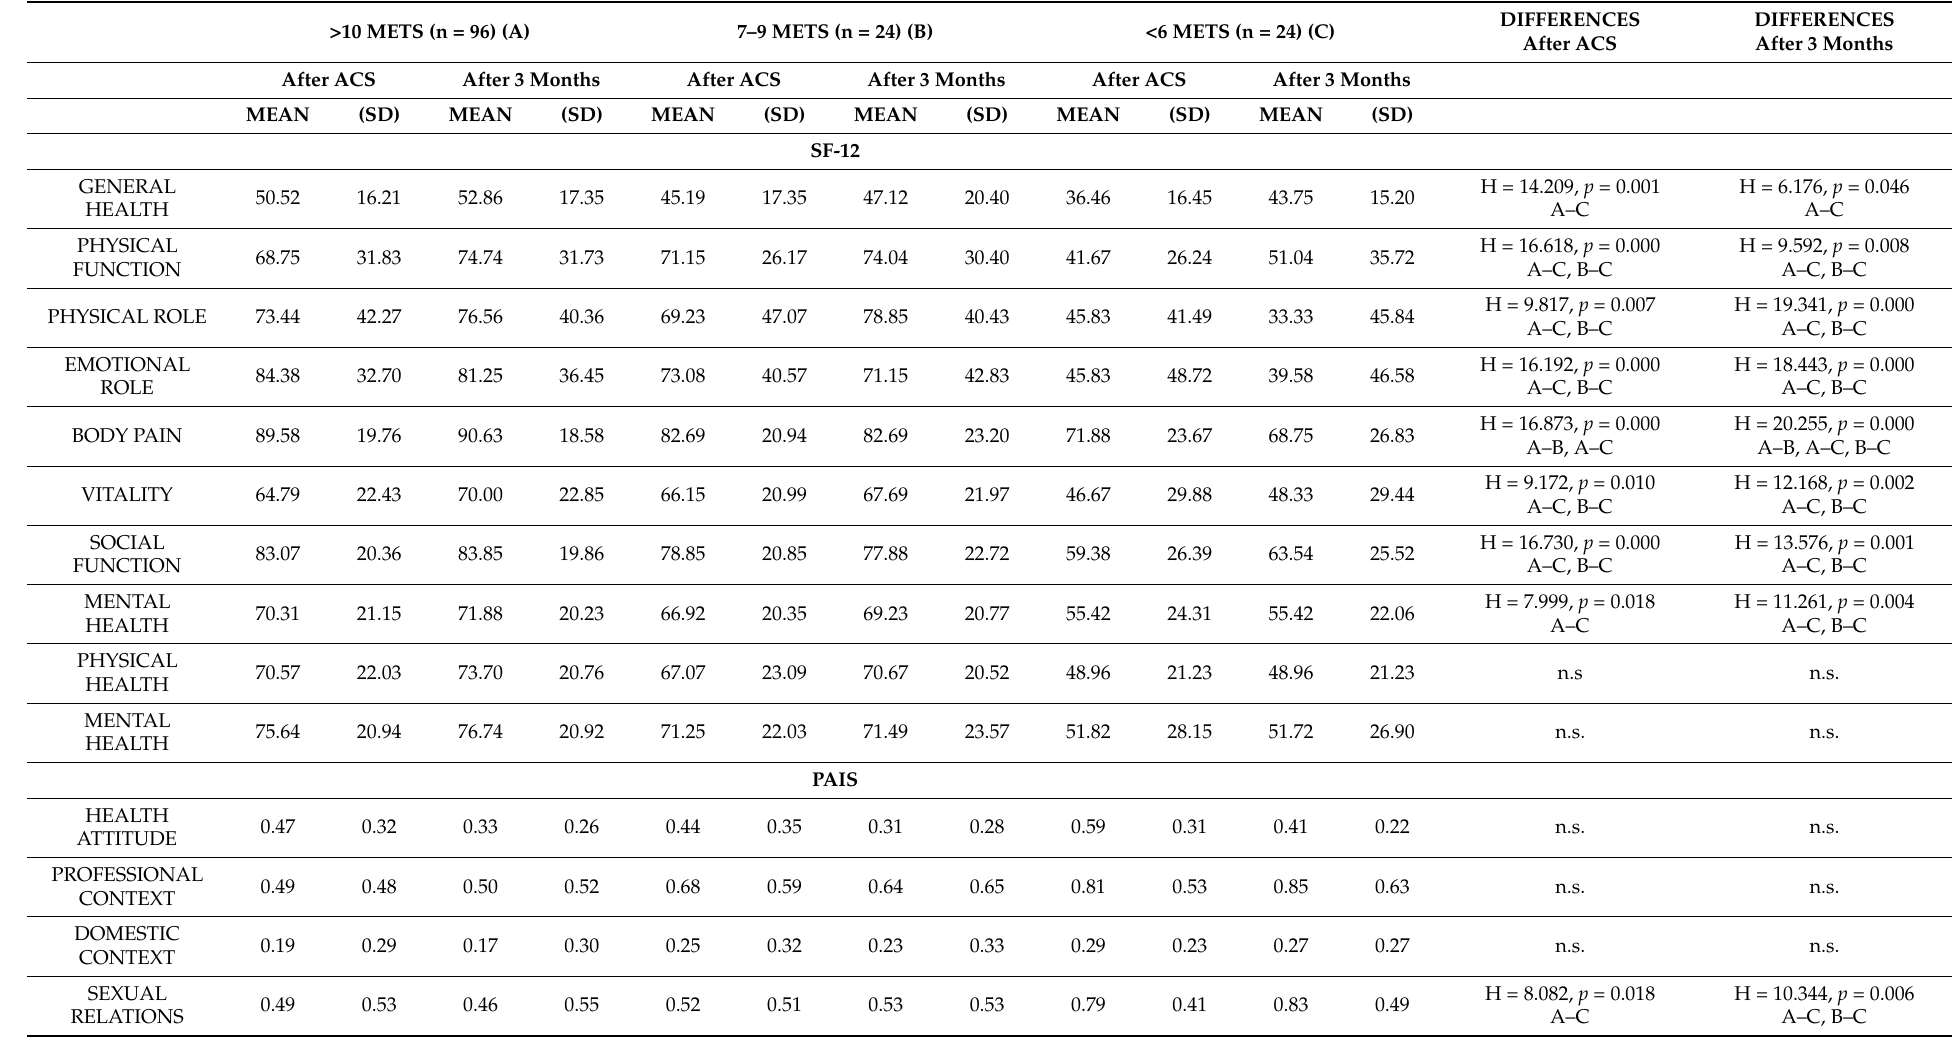
Table 2. Mean and standard deviation in the three groups of the following tests: SF-12, PAIS, HAD and PTGI. Two last columns report statistical differences between groups (first column after ACS and the second after 3